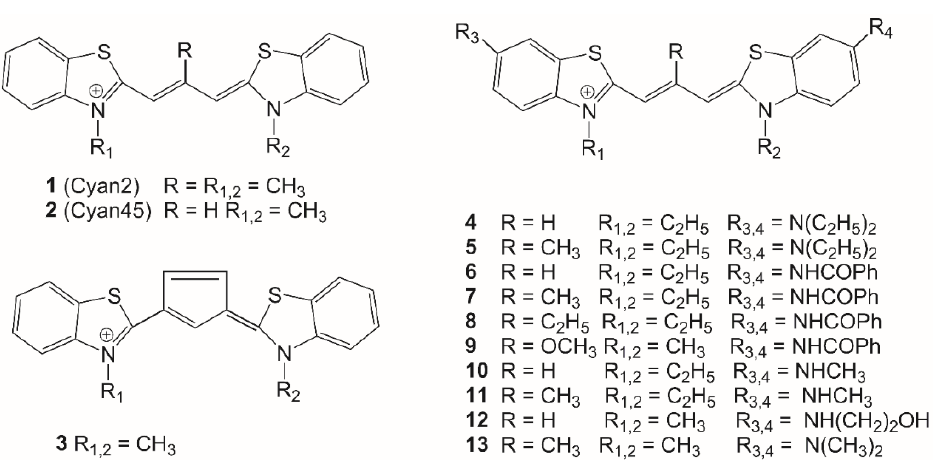
Figure 5. Structures of cationic trimethine cyanines 1 – 13 .